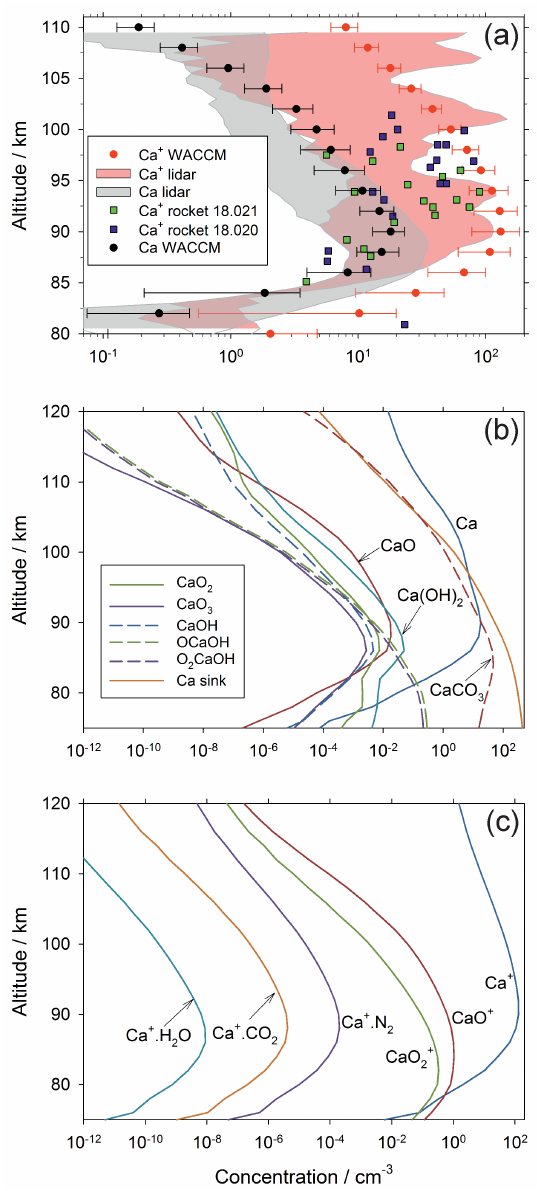
Figure 4. Annual mean concentration profiles of Ca species over Kühlungsborn (54 ◦ N): (a) comparison of WACCM-Ca model re- sults (the horizontal error bars indicate 1 standard deviation from the mean) with the lidar measurements of Ca and Ca + (the shaded areas encompass 1 standard deviation from the mean). Note that the model output was sampled to the lidar data over the same pe- riod between 1997 and 2000. Also shown are mass spectrometric measurements of Ca + made by two rockets which were launched from Red Lake (50.9 ◦ N, Canada), on 24 February 1979 11:52LT and 26 February 1979 11:55LT (payloads 18.020 and 18.021; Kopp and Herrmann, 1984; Kopp, 1997); (b) modelled vertical profiles of neutral Ca species in WACCM-Ca, where “CaCO 3 ” = CaCO 3 + O 2 CaCO 3 + OCaCO 3 ; (c) modelled vertical profiles of ionic Ca species in